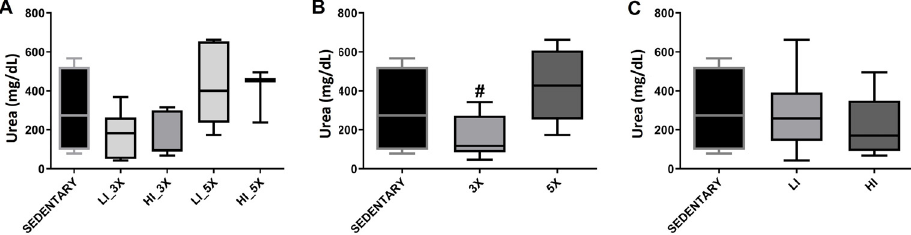
Figure 3. Median and interquartile range of concentration of urea in the plasma of sedentary, trained at low (LI) and high (HI) intensity, three times (3X) and fi ve times (5X) per week groups ( A ) and according to animals grouped by training frequency (three and fi ve times per week) ( B ) and training intensity (low and high intensity) ( C ). # P o 0.05 compared with 5X group (P o 0.05; Figure 6A). When grouped by training frequency, mice trained three times per week showed signi fi cantly higher GPx activity than the sedentary group (P o 0.05; Figure 6B). Likewise, when grouped by intensity, animals trained at low intensity showed signi fi cantly higher GPx activity than the sedentary group (P o 0.05; Figure 6C).